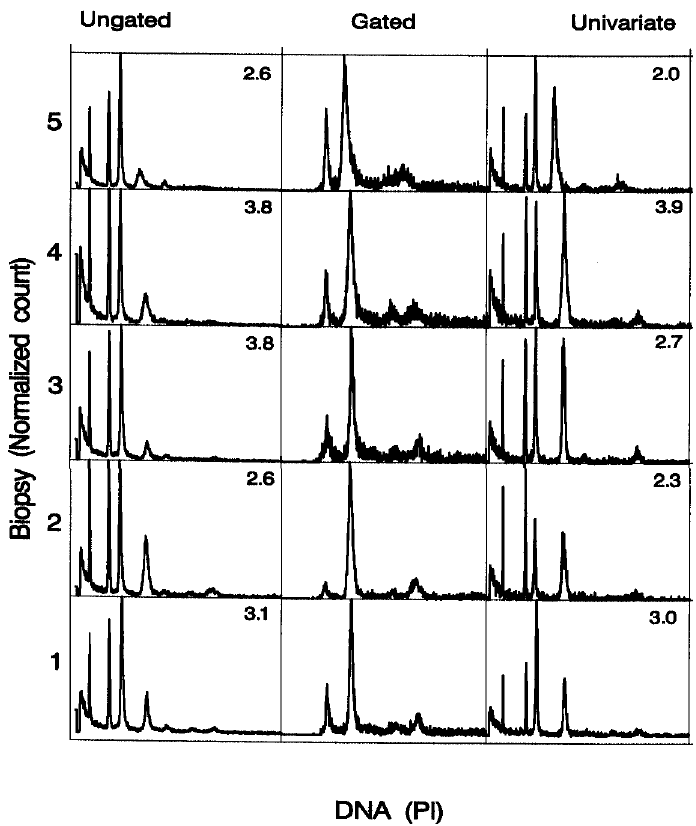
Fig. 2. Cytokeratin-ungated, cytokeratin-gated (positive) and univariate DNA histograms of one patient, represented with 5 tumor biopsies. The aneuploid peak is clearly higher in cytokeratin-gated than in ungated, in histograms of all of the 5 biopsies. The CV is indicated in the upper right